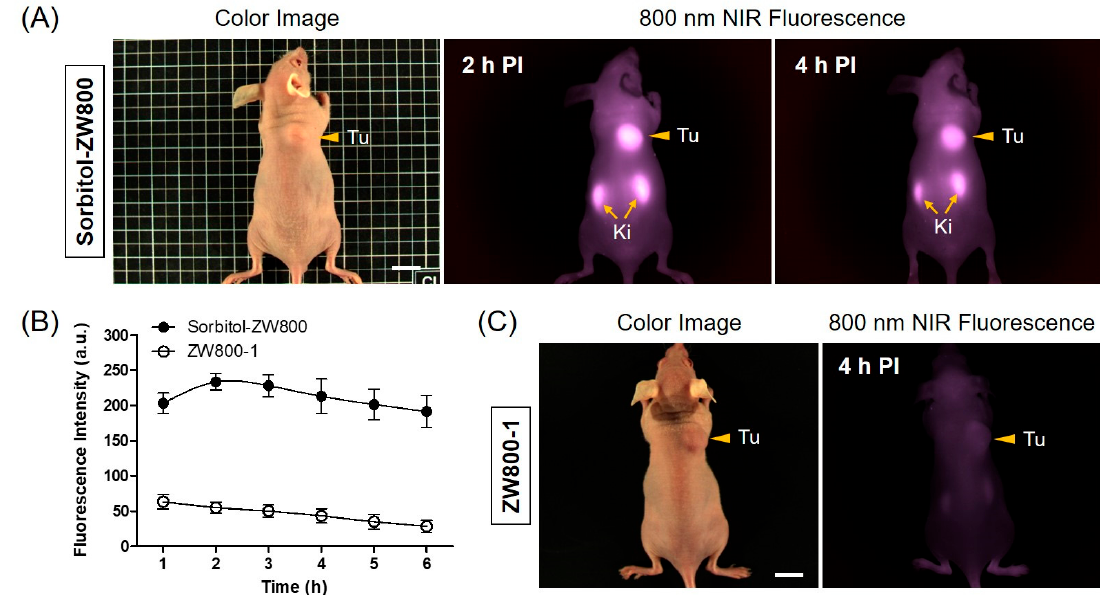
Figure 3. In vivo HT-29 tumor targeting efficiency of sorbitol–ZW800 and ZW800-1 alone. ( A ) NIR fluorescence imaging at 2 h and 4 h post-injection of sorbitol–ZW800. ( B ) Time-dependent fluorescence intensities of tumor sites targeted by sorbitol–ZW800 and ZW800-1 alone. ( C ) NIR fluorescence imaging at 4 h post-injection of ZW800-1 alone. Tumor mice were intravenously injected with sorbitol–ZW800 or ZW800-1 alone (10 nmol, 0.4 mg / kg) and imaged for 24 h. The tumor site is indicated by arrowheads. Abbreviations: Tu, tumor; Ki, kidneys; and PI, post-injection. Scale bars = 1 cm. Images are representative of three independent experiments. All NIR fluorescence images have identical exposure and normalizations. Data are expressed as mean ± S.D. of three independent experiments.